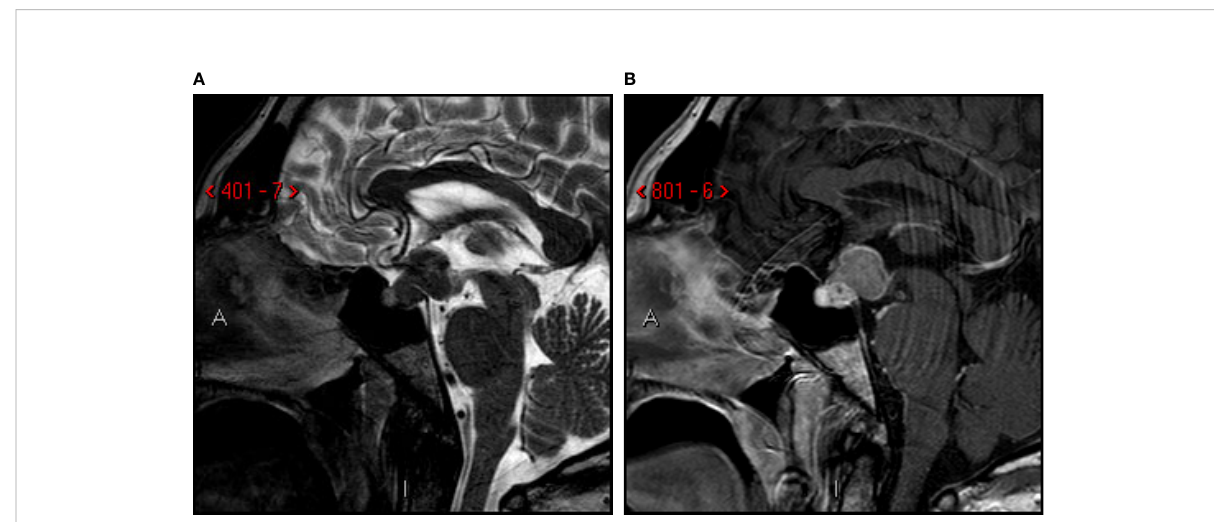
FIGURE 1 First MRI-scan. Sagittal T2-weighted (A) and post-contrast T1-weighted (B) images. Sellar and suprasellar mass involving posterior lobe and infundibulum of the pituitary gland, with low signal on T2-images. Compression of mammillary body, optic chiasm and tracts, third ventricle (infundibular recess).